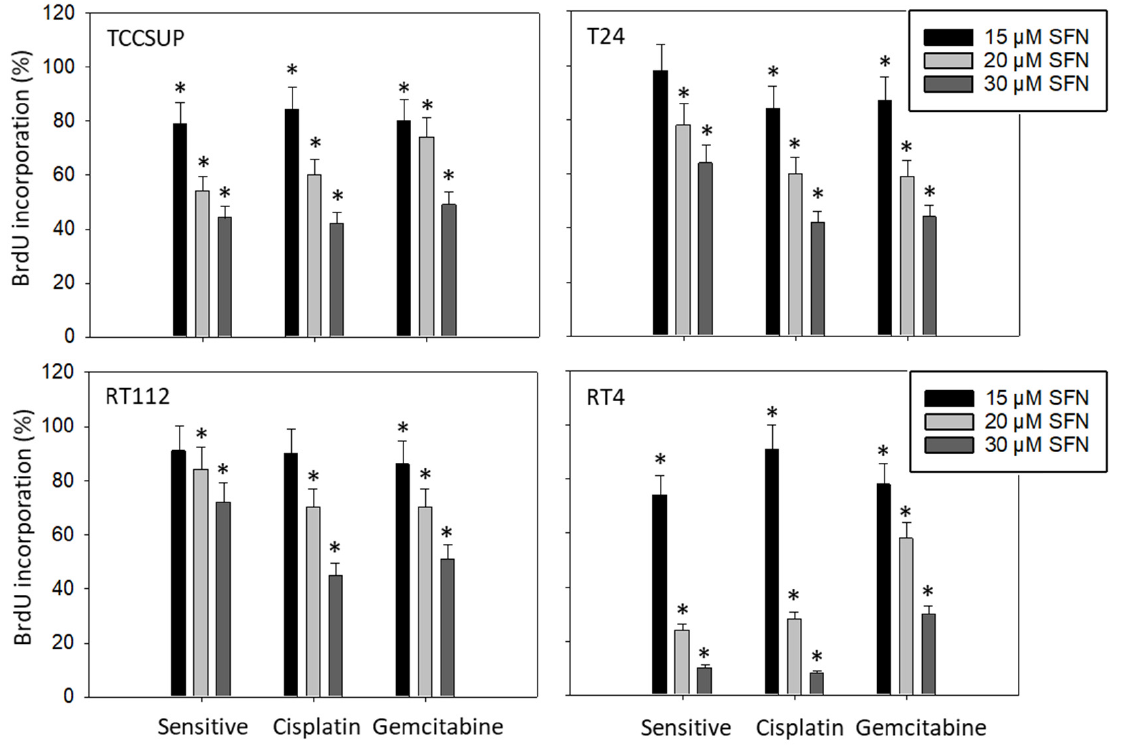
Figure 4. Influence of 15, 20, and 30 µM SFN on the proliferation of sensitive and cisplatin- and gem-citabine-resistant TCCSUP, T24, RT112, and RT4 bladder cancer cell lines. Evaluation by BrdU incorporation after 48 h. Error bars indicate the standard deviation. * indicates a significant difference compared to untreated controls set to 100%. n = 3.